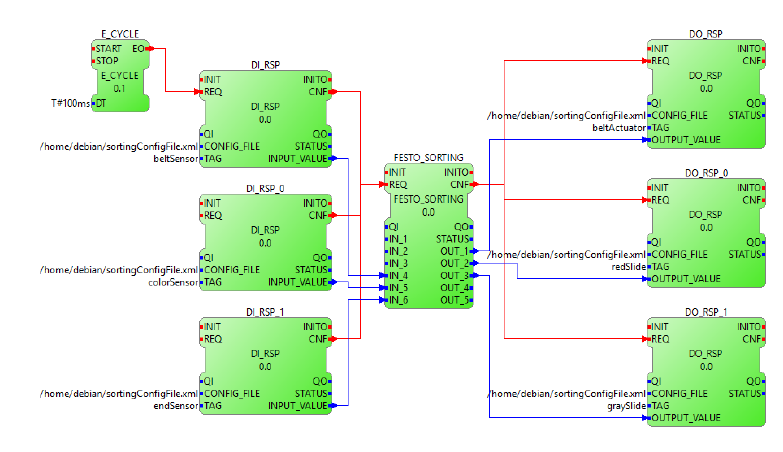
Figure 13. Sorting application under IEC 61499 for batch